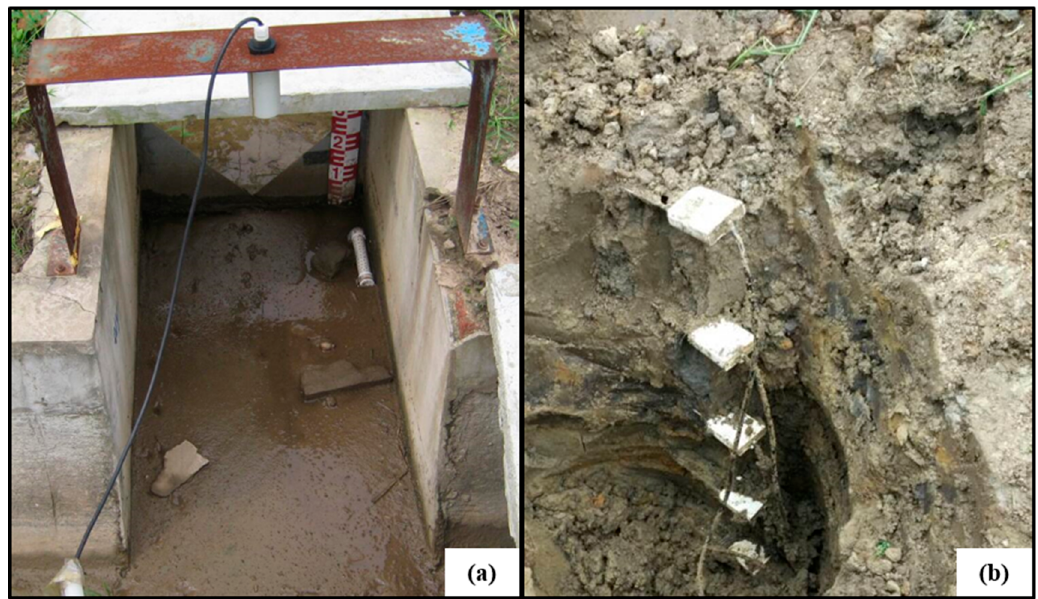
Figure 2. Measuring instruments: ( a ) the V-notch weir at the outlet; ( b ) the soil water profile measuring sensors.